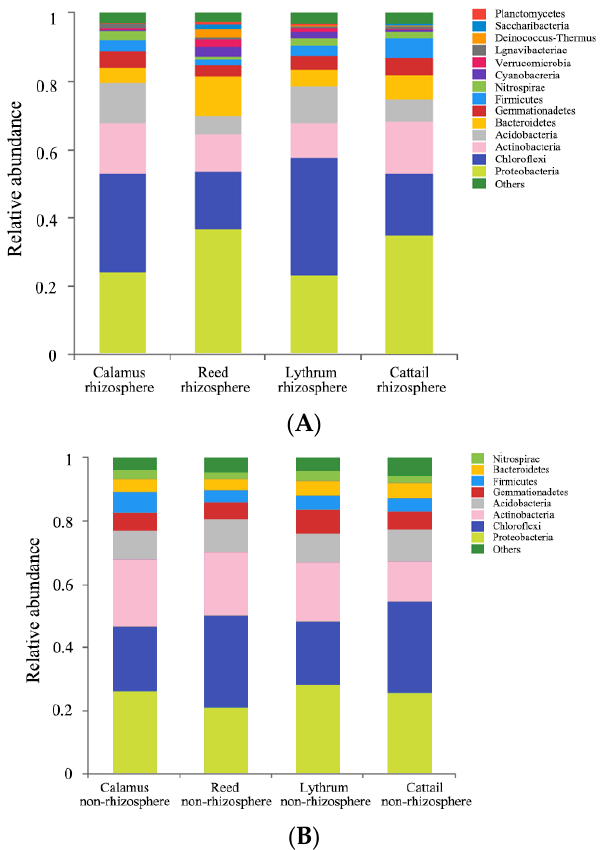
Figure 11. Species structure in the eco-ditch ( A ) and in the soil ditch ( B ).